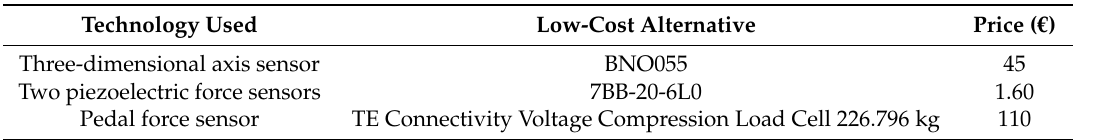
Table 2. Alternative low-cost sensors proposed for each